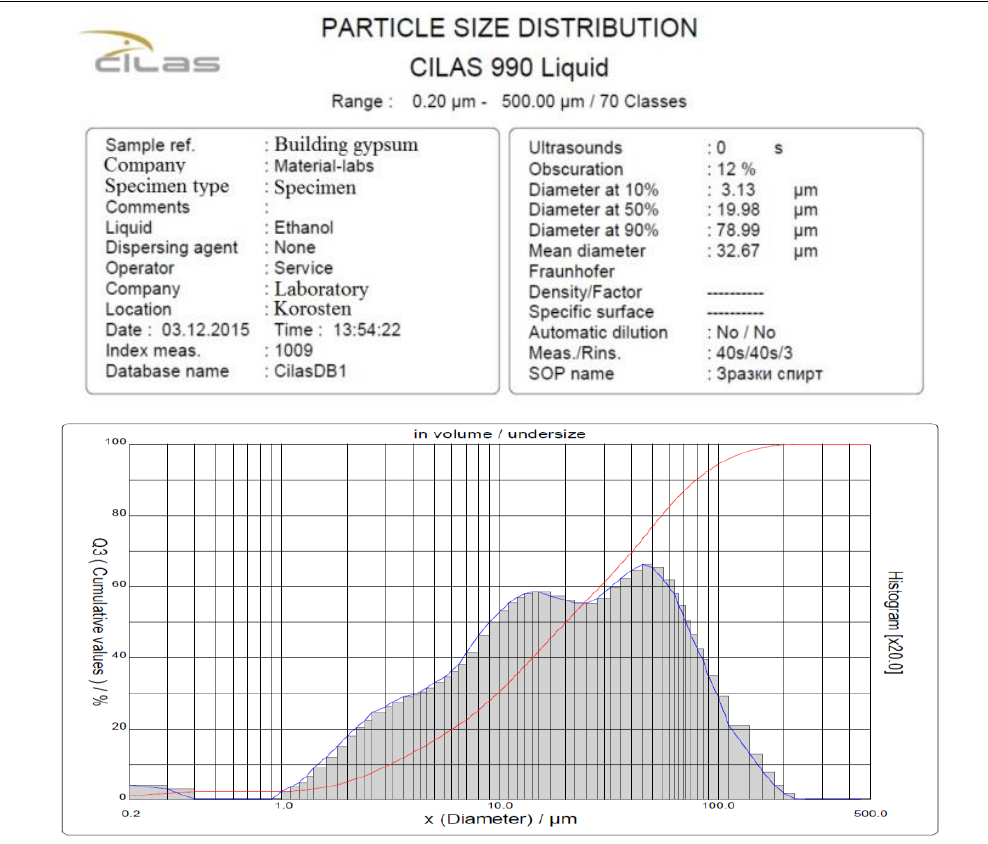
Figure 3. Differential particle sized distribution curve for building gypsum.